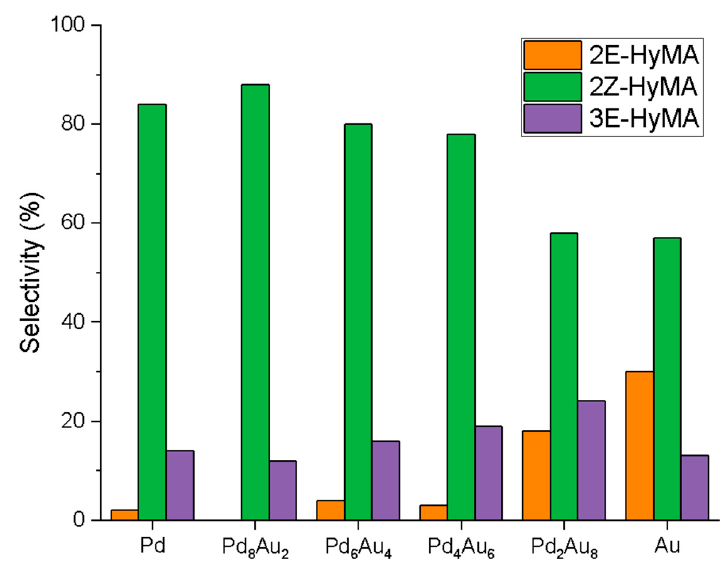
Figure 7. Intermediate selectivity after 30 min of reaction.